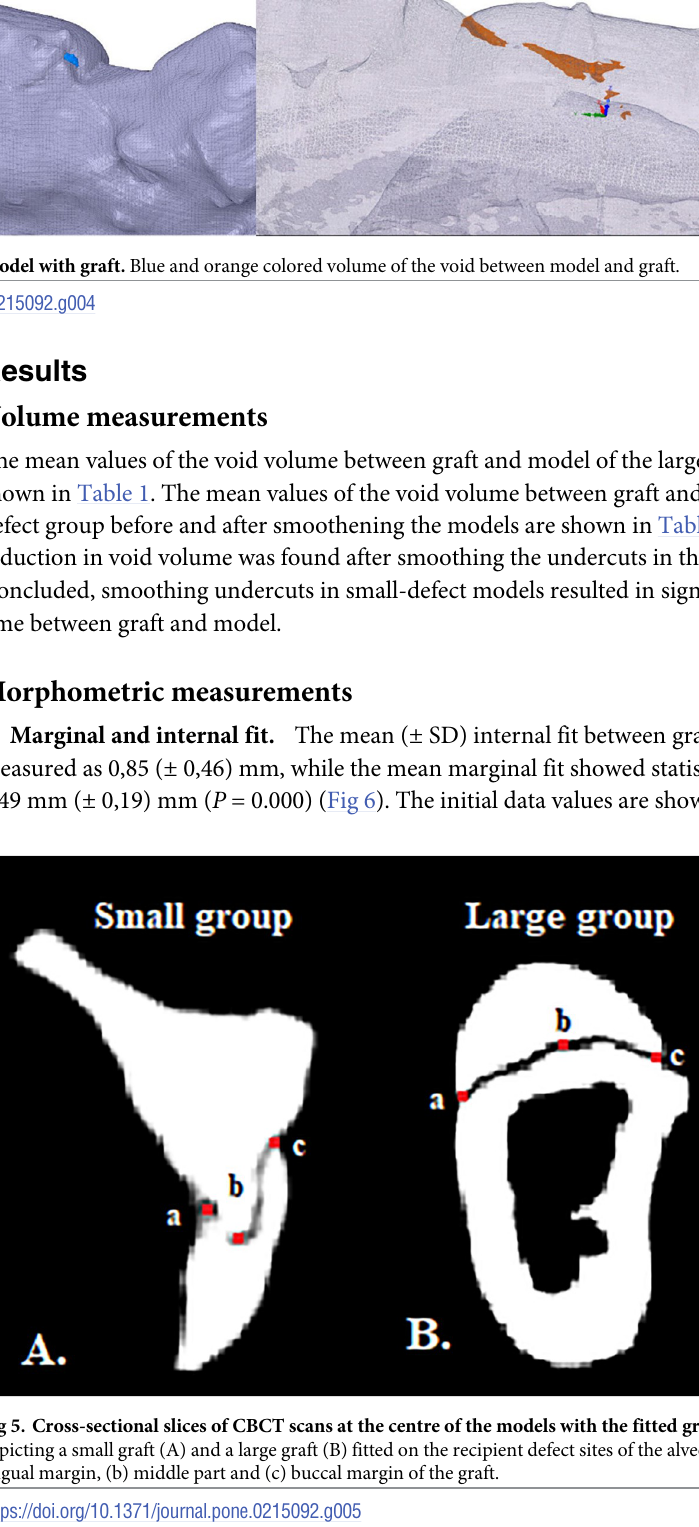
PLOS ONE | https://doi.org/10.1371/journal.pone.0215092 April 15,